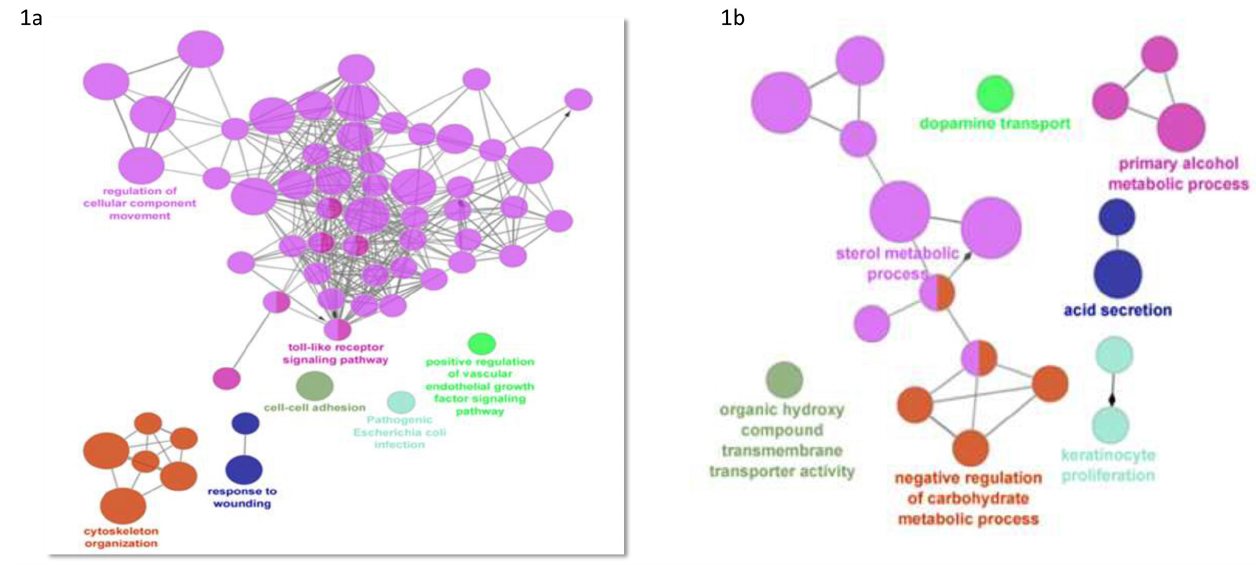
Figure 1. Protein-protein interaction networks (PPIs) of DEGs were constructed using STRING database. Gene ontology analysis was performed for functional analysis of DEGs by using ClueGo app from Cytoscape. This app allows simultaneous analysis of multiple annotation and ontology sources. Functionally grouped network is represented Figure 1a (upregulated genes) 1b (downregulated genes) . The node size represents enrichment significance and connections are based on kappa score (> 0.4). In upregulated gene group maximum number of nodes which are in pink color represent the cellular component movement. These nodes are shared by toll like receptor signaling